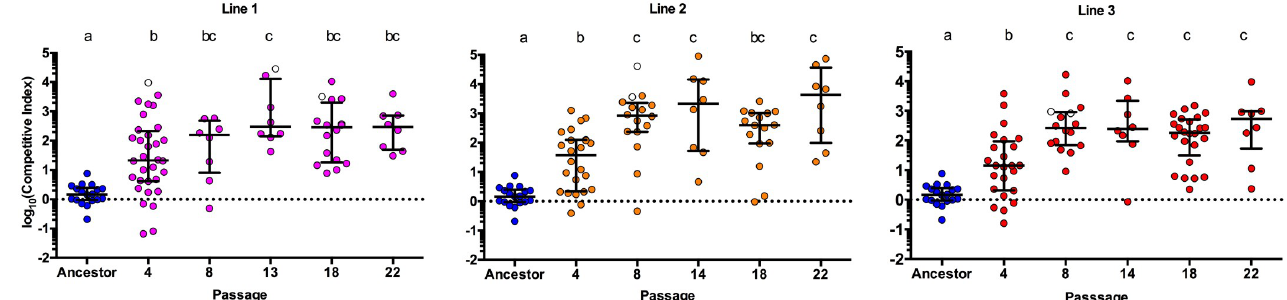
Fig 2. Adaptation of Aer01 occurred quickly and reproducibly across replicate lines. CIs of the test strain (evolved isolates or the ancestor) when competed against a differentially tagged ancestral reference strain in the larval fish. CI = (test/reference) end /(test/reference) start . Each circle represents a CI from an individual fish. Open circles represent data points at which the reference strain was undetected on plates; therefore, CIs were calculated by setting the abundance of the reference strain to the limit of detection (5 CFU/gut), thus providing a lower bound for the CI for these points. Ancestral data are the same in all plots. Median and interquartile ranges are plotted for all data. Conditions that share a letter are not statistically different (ANOVA, log-transformed data). n � 8 fish/ condition. Dotted line indicates CI value in the absence of any competitive advantage. Underlying data are provided in S1 Data. CFU/gut, colony-forming unit per gut; CI, competitive